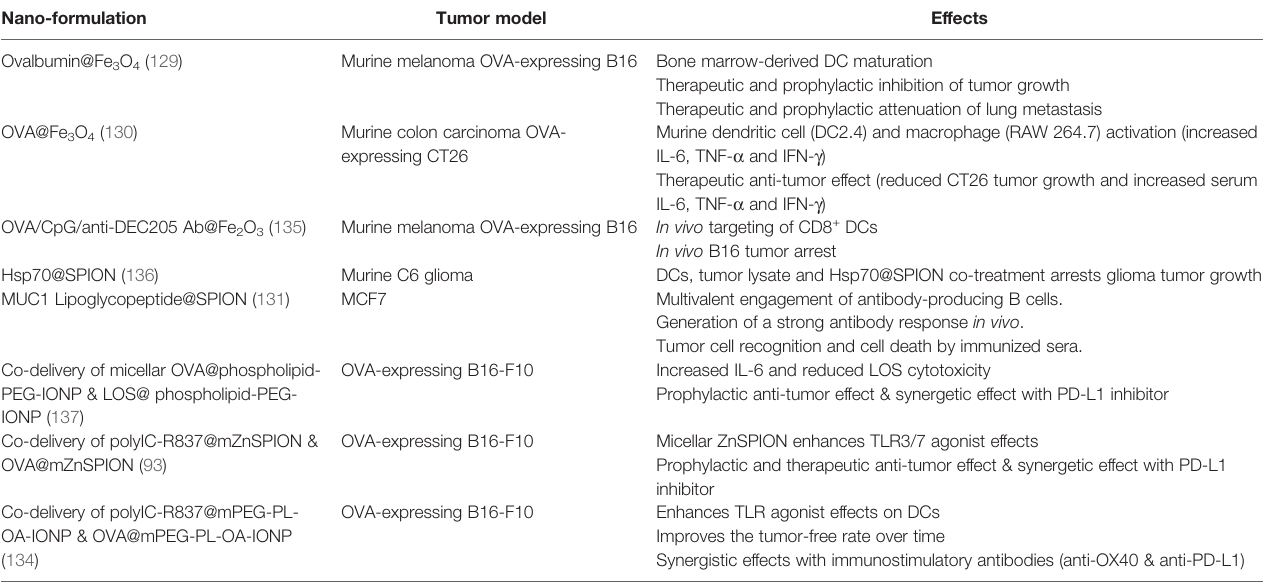
TABLE 4 | Use of IONPs in vaccine